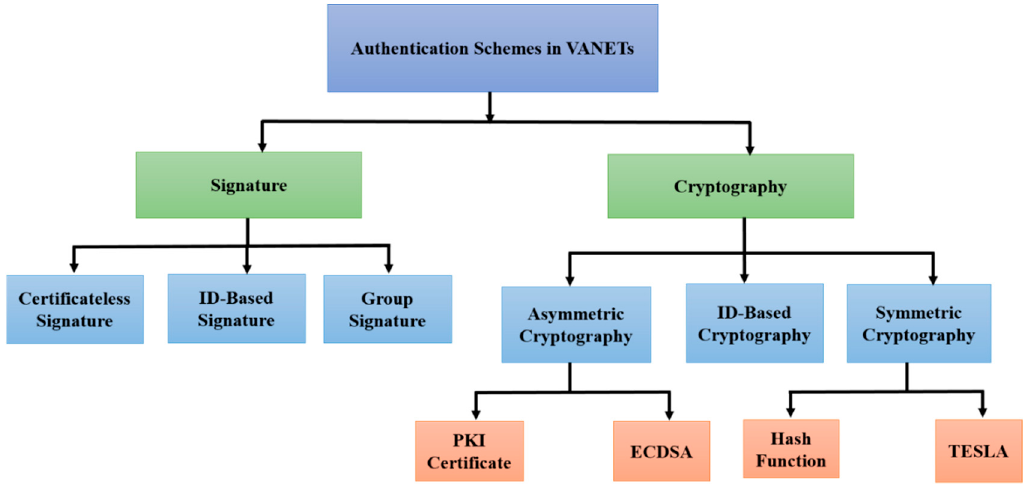
Figure 5. Authentication scheme classification in vehicular ad hoc networks (VANETs).